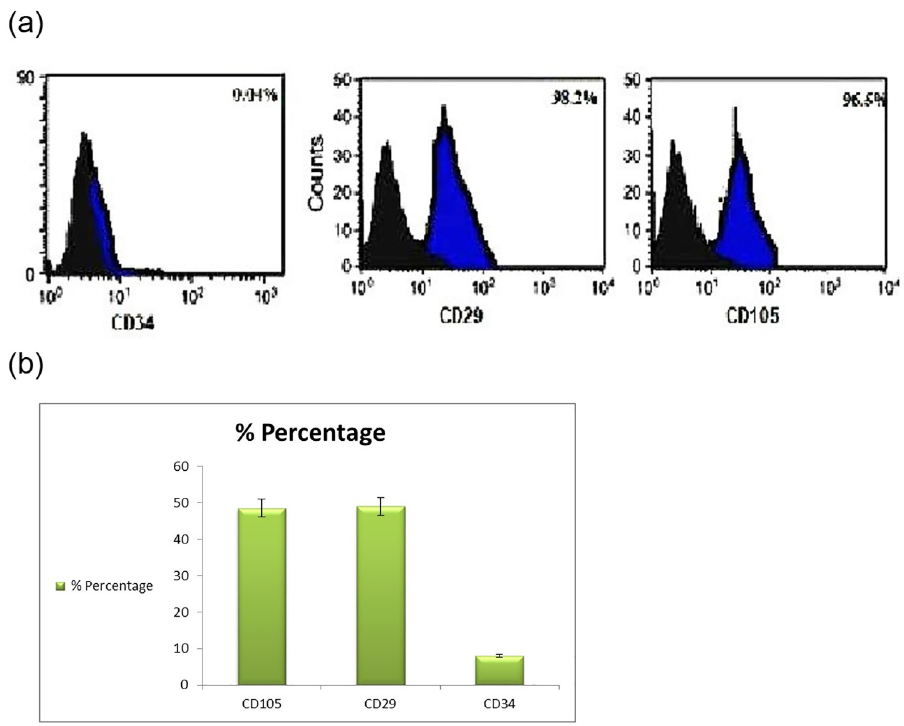
Fig 9. Flow cytometry results of the mesenchymal stem cell markers CD34, CD29, and CD105. MSCs highly expressed CD29 and CD105 ( > 95%) and weakly expressed CD34 ( < 5%). There is a significant difference in CD105, CD 29 and CD 34 expression between bone marrow derived mesenchymal stem cells (P < 0.001). The black area represents IgG (negative control) expression, and the blue areas depict marker expression. The results are representative of three independent experiments. Data are presented as mean ± S.D.